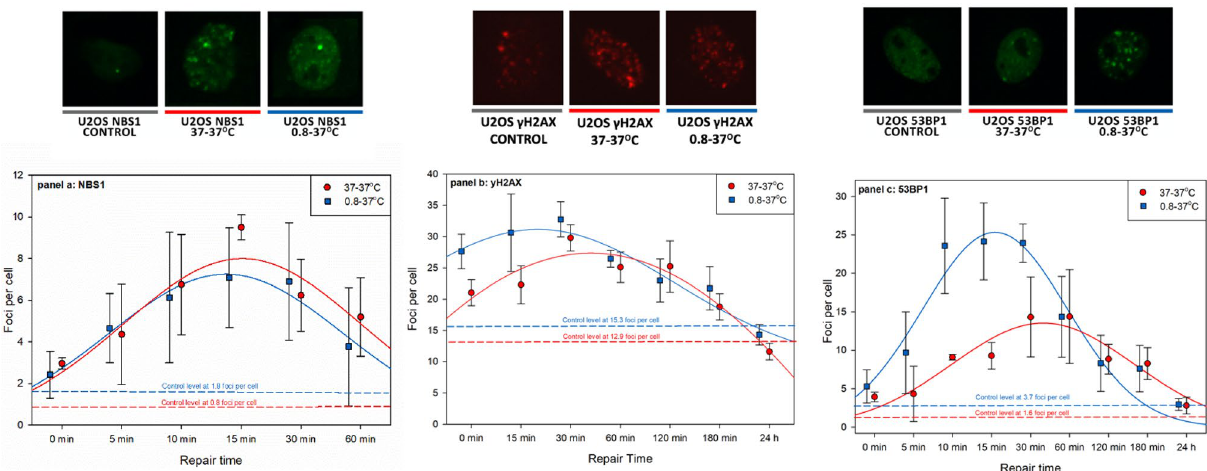
Figure 2. Impact of temperature at exposure: kinetics of NBS1 ( a ), γH2AX ( b ) and 53BP1 ( c ) foci formation and decay in U2OS cells exposed to 2 Gy of gamma radiation at 37 °C or 0.8 °C and allowed to repair at 37 °C. Time scale is not proportional. See Fig. 1A for an explanation of the treatment groups. Horizontal dashed lines represent control levels of foci. Error bars represent standard deviations from 3 experiments. AUC values were analysed by Cohen’s effect size test and by two-sided Student’s t test, assuming unequal variance. The results are described in the text. Images show representative nuclei with foci fixed 15 min post exposure. No counterstaining of nuclei was